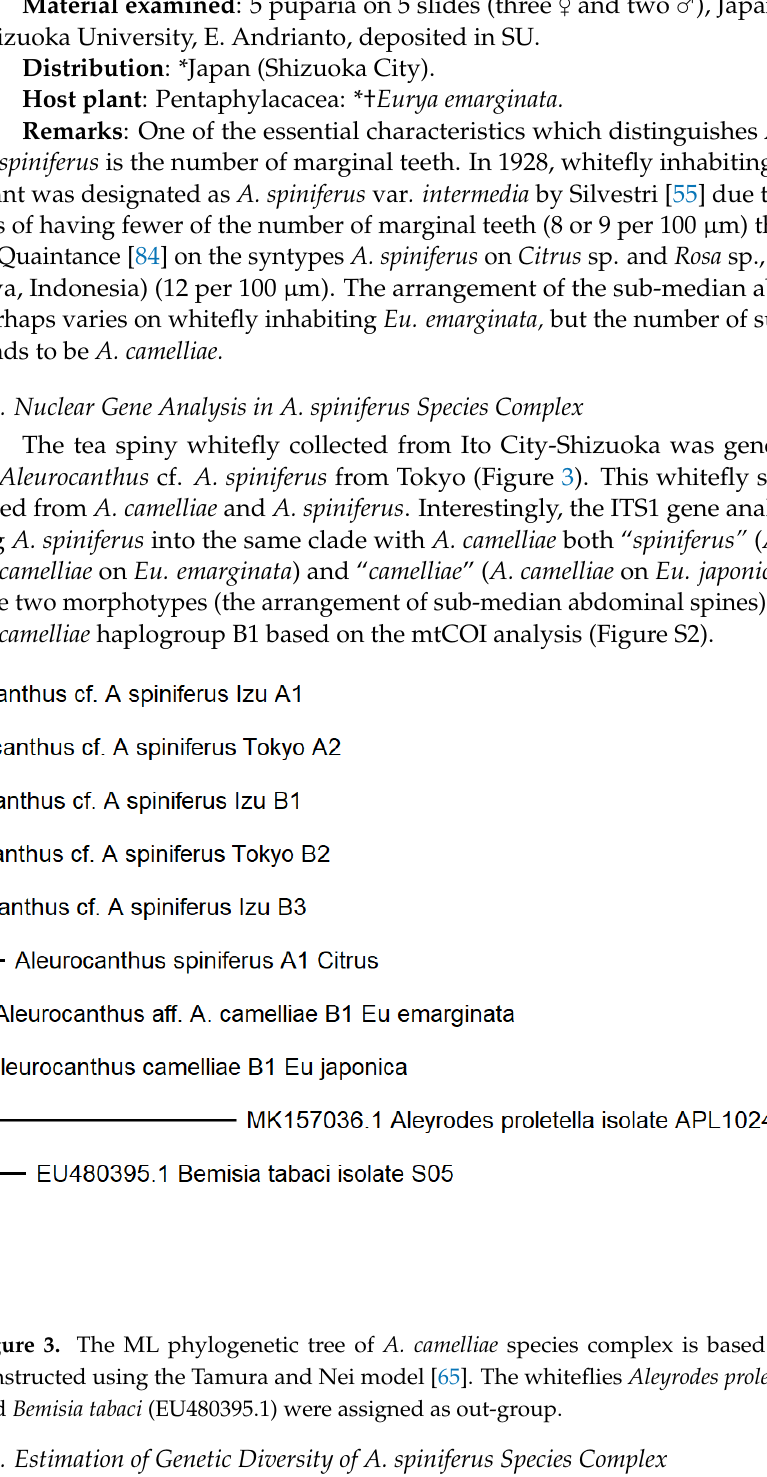
Table 2. Haplotype diversity of the Aleurocanthus spiniferus species complex was estimated from 450 bp COI-2 sequences retrieved from the NCBI database. A. spiniferus species complex includes A. camelliae, A. spiniferus, and A. woglumi sequences. Gene